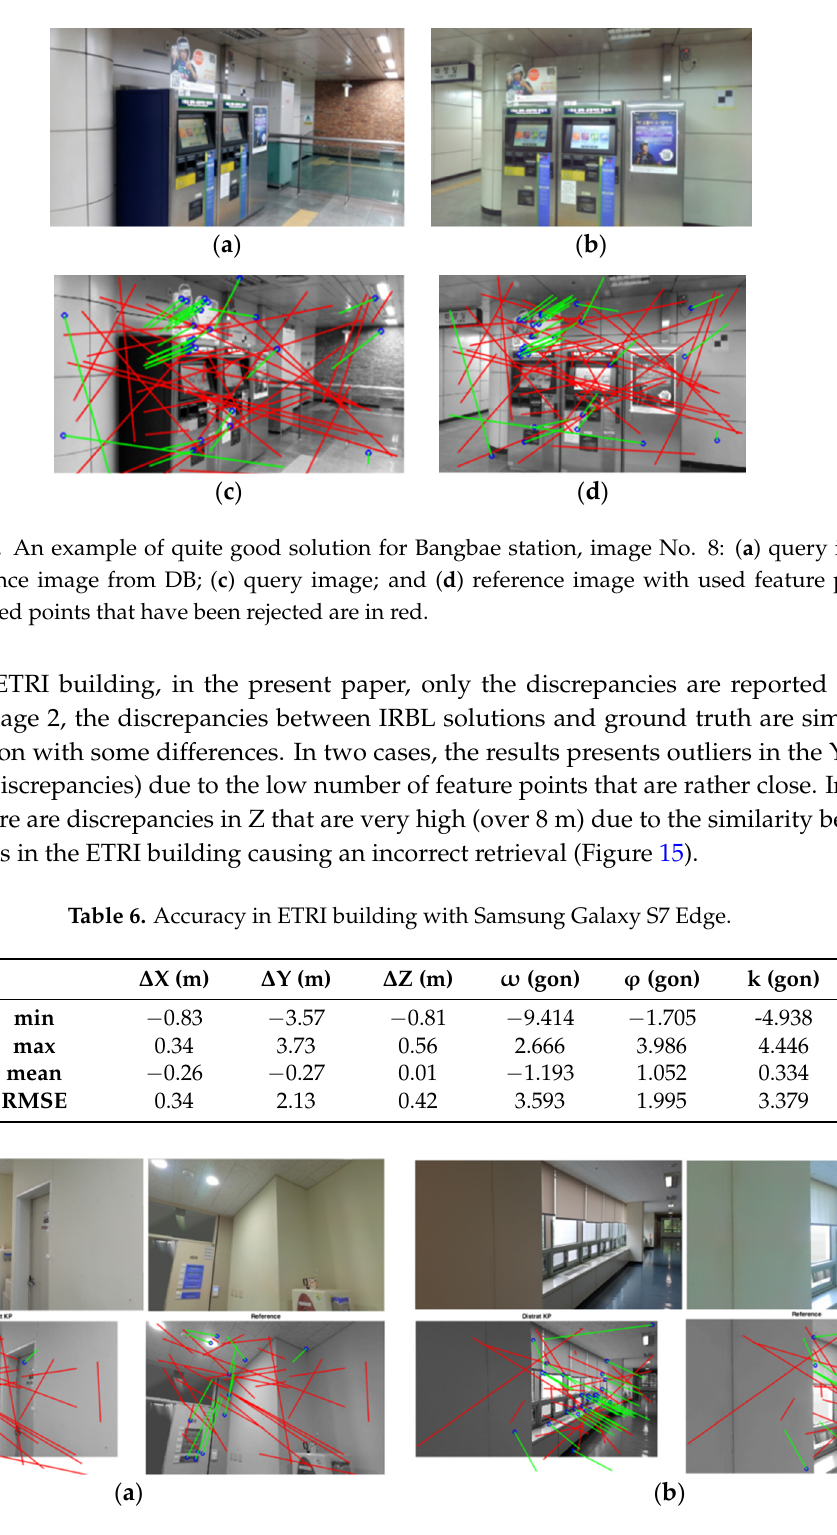
Figure 13. A good solution for Bangbae station, Image 17: ( a ) query image; ( b ) reference image from DB; ( c ) query image; and ( d ) reference image with used feature points; the matched points that have been rejected are in red.